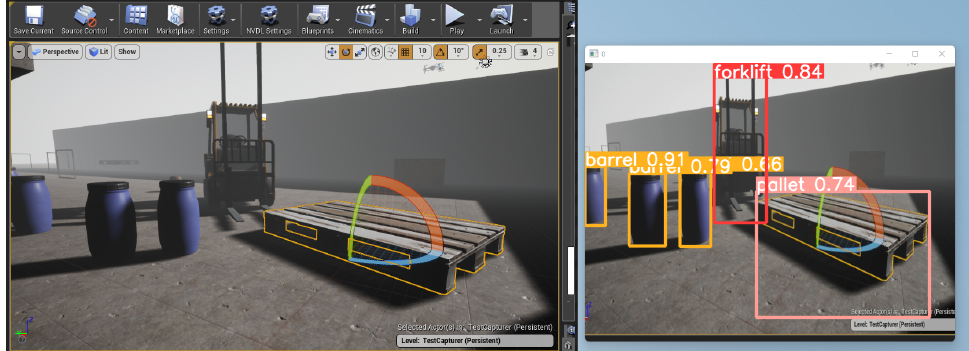
Figure 8. Inference while operating the UE4 environment.